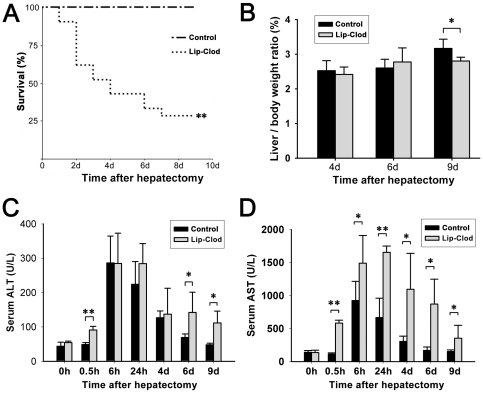
Effect of KC depletion on liver damage and regeneration and rat survival after PH.Accumulated survival rate (A). liver weight/body weight ratio (B). Blood serum levels of ALT and AST (C and D). (Data represent mean ± SD, n = 4–5. * P<0.05; ** P<0.01).